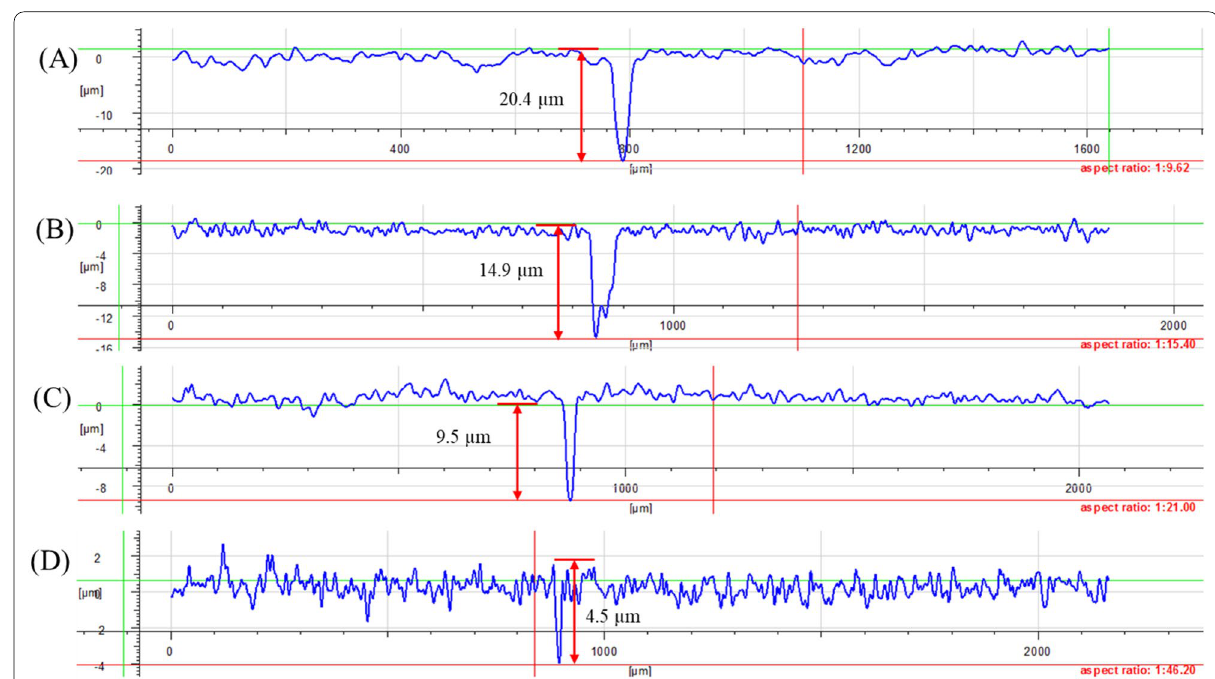
Fig. 9 Pit depths of C1018 carbon steel coupons after 7-day biofilm prevention test in flow loop bioreactors: A no treatment, B 50 ppm THPS, C 50 ppm THPS 100 nM Peptide A, D 100 ppm +